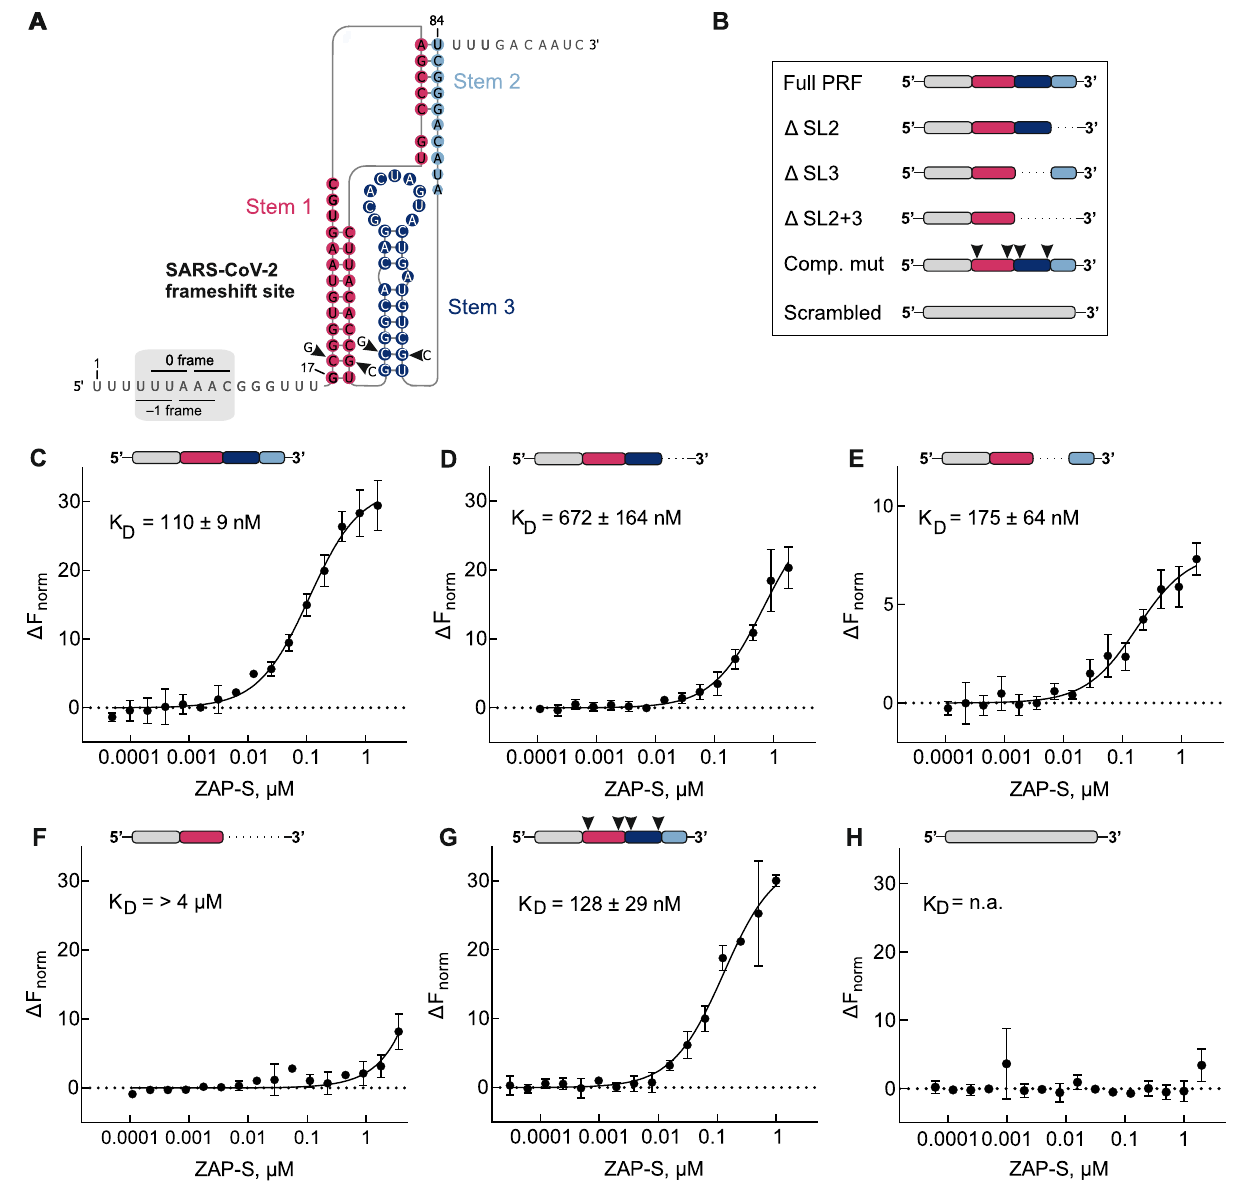
Fig. 4 In vitro characterization of ZAP-S interaction with SARS-CoV-2 – 1 PRF RNA. A Proposed structure of the PRF element of SARS-CoV-2. Nucleotide substitutions in the compensatory mutant are indicated (arrowheads). B Schematic representations of the RNAs studied. C – H Microscale thermophoresis assay to monitor ZAP-S binding to ( C ) Full PRF, ( D ) Δ SL2 mutant, ( E ) Δ SL3 mutant, ( F ) Δ SL2 + 3 mutant, ( G ) compensatory mutant, ( H ) scrambled mutant. Unlabeled protein (40 pM – 2 µ M) was titrated against 3 ′ pCp-Cy5 labeled RNA (5 nM) and thermophoresis was recorded at 25 °C with 5% LED intensity and medium MST power. Change in fl uorescence ( Δ F norm ) was measured at MST on-time of 2.5 s. Data were analyzed for Δ F norm using standard functions of MO. Af fi nity Analysis software and data was plotted and K D was determined using Graphpad Prism 9.2.0. Data represent mean ± s.d. of three measurements ( n = 3). For the related thermophoretic traces, see also Supplementary Fig. 4A-F. For the related DNA sequences of the mutants, see